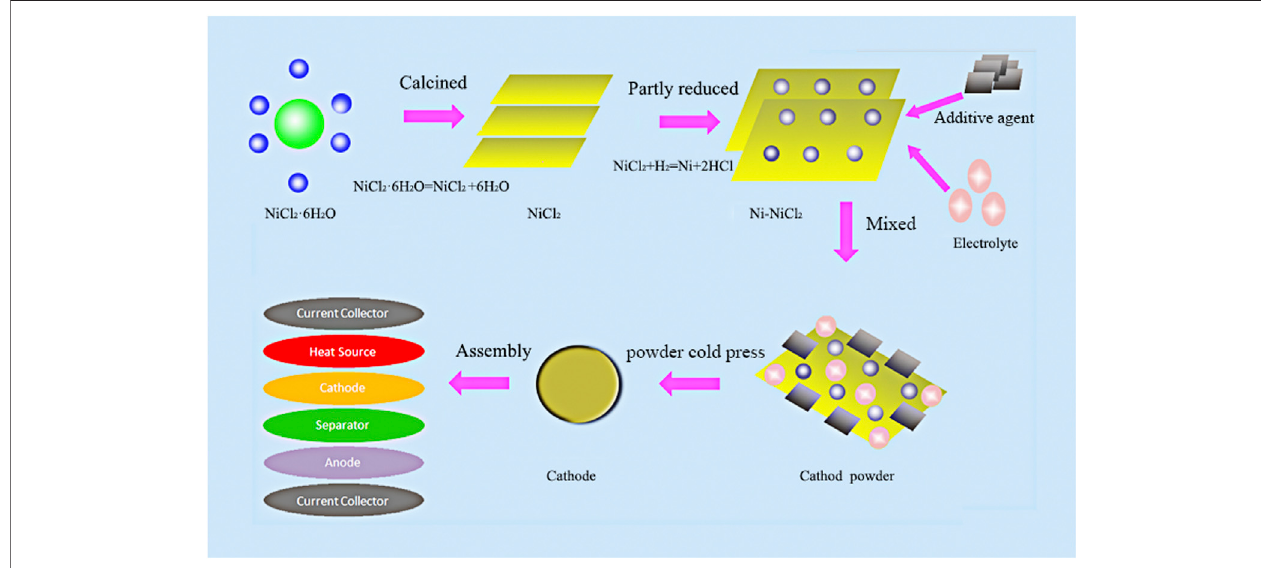
FIGURE 1 | Schematic illustration of the preparation of Ni-NiCl 2 composite cathode material and the assembly of the thermal battery.